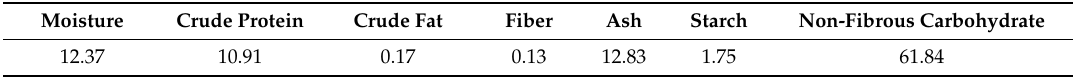
Table 1. Nutrient composition of SWP